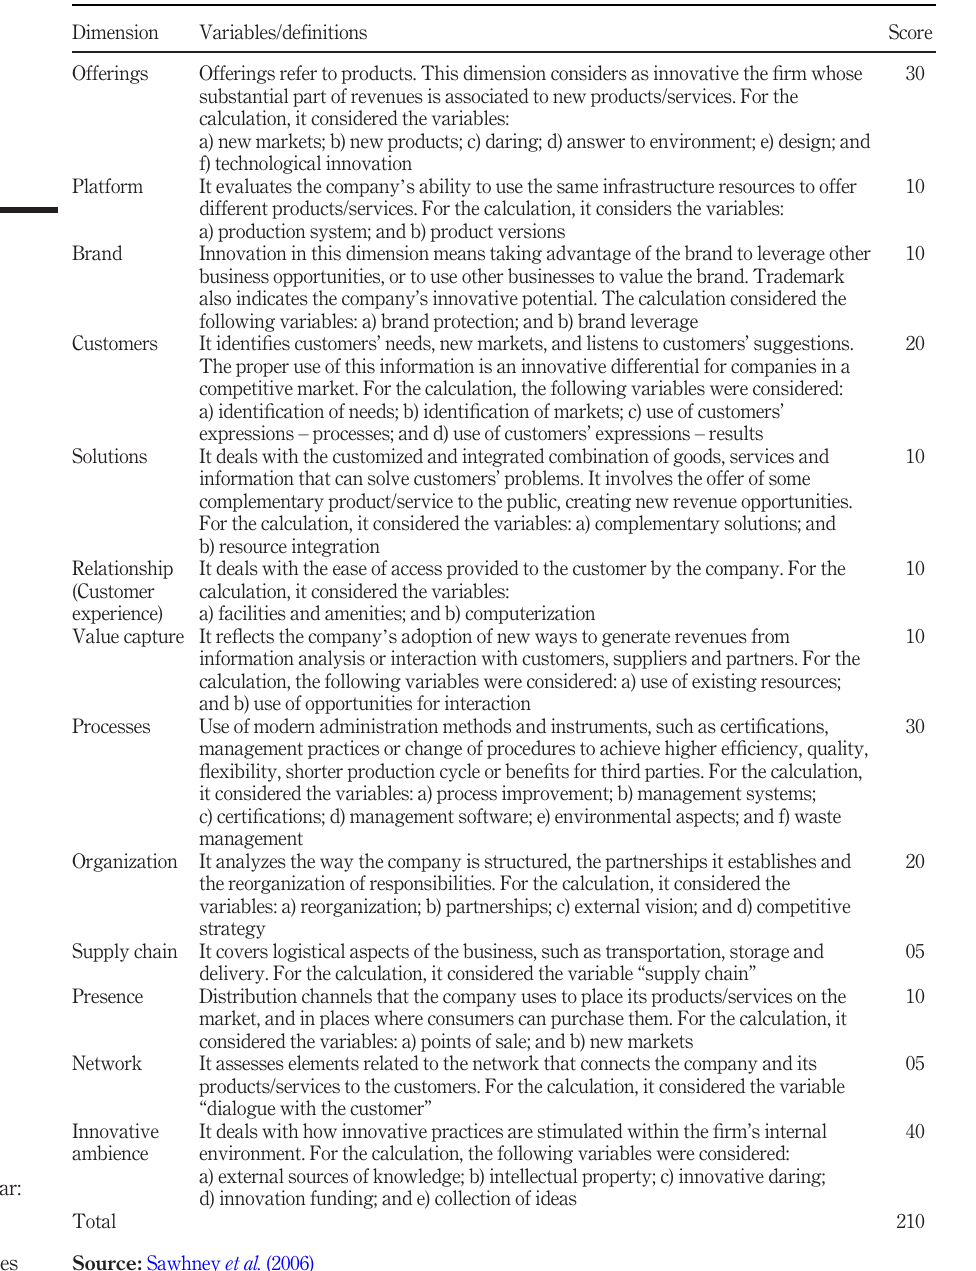
Table II. Innovation radar: dimensions, variables and maximum